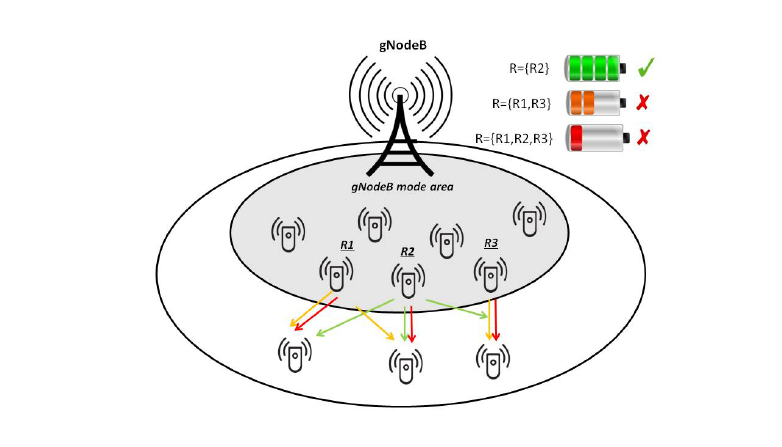
Figure 1. Energy Efficient D2D over Single Frequency Network (EED2D-SF)